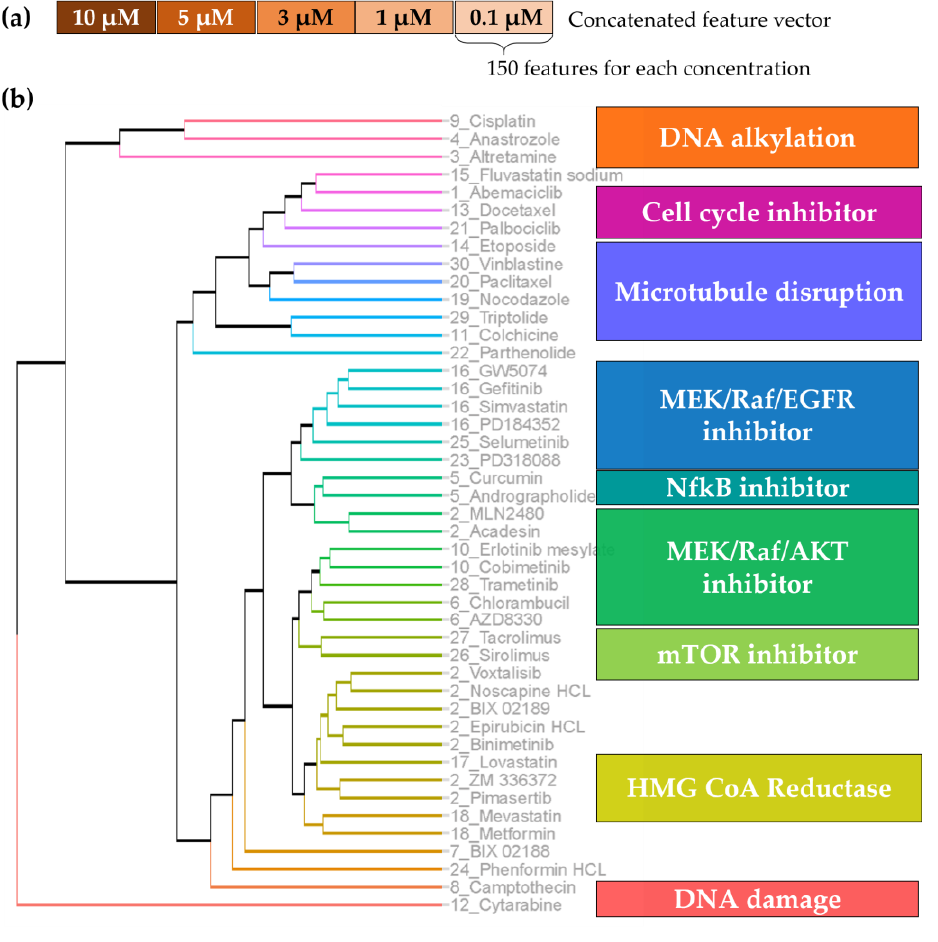
Figure 6. ( a ) Concatenated feature vector used for clustering consists of five drug concentrations with the same 150 features each. ( b ) Hierarchical clustering of 48 active compounds.